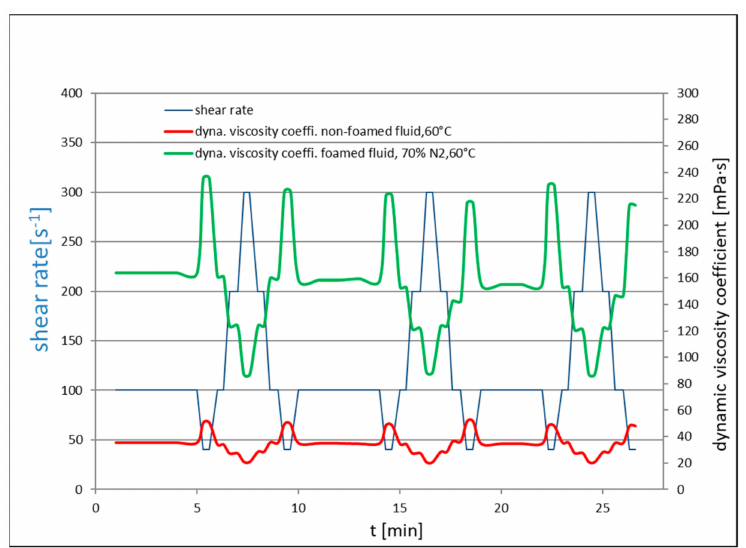
Figure 4. Viscosity of non-foamed FF1A and N 2 -foamed FF1B fluid of 70% quality at 60 ◦ C.